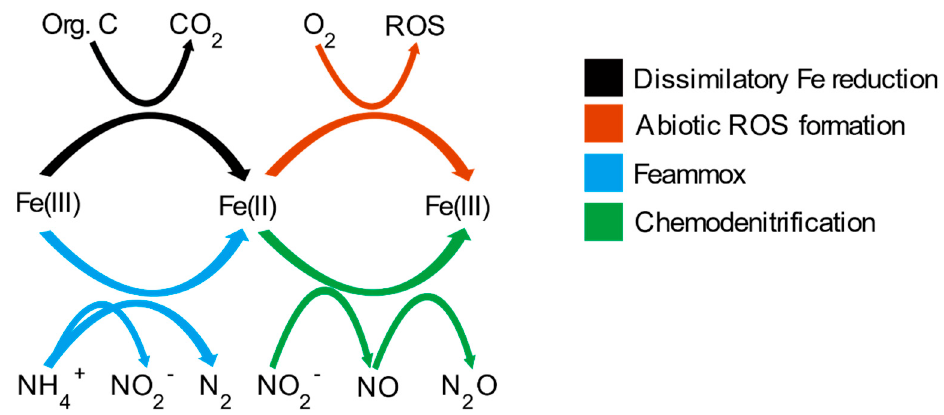
Figure 1. Conceptual diagram showing the four main Fe mediated C and N transformations considered in this study: Dissimilatory Fe reduction, abiotic reactive oxygen species (ROS) formation, anaerobic ammonium oxidation coupled to Fe reduction (Feammox), and chemodenitrification. While C is not directly lost via ROS production, ROS can stimulate the abiotic degradation of soil organic matter (SOM). Arrows originate at the starting reactant and end at the product. Colors correspond to different reactions coupling Fe reduction or oxidation with C and N transformations.